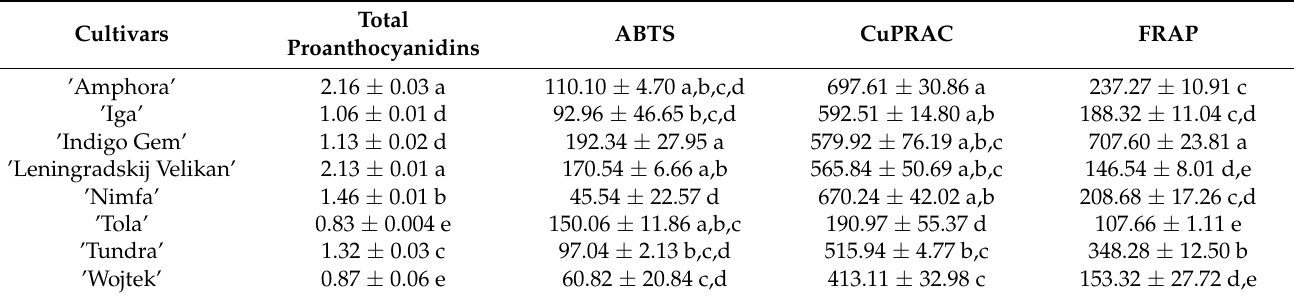
Table 7. Antioxidant activity ( µ mol/g, TE DW (Trolox equivalents)) and total amounts of proanthocyanidins (mg/g, DW) in cultivars of L. caerulea